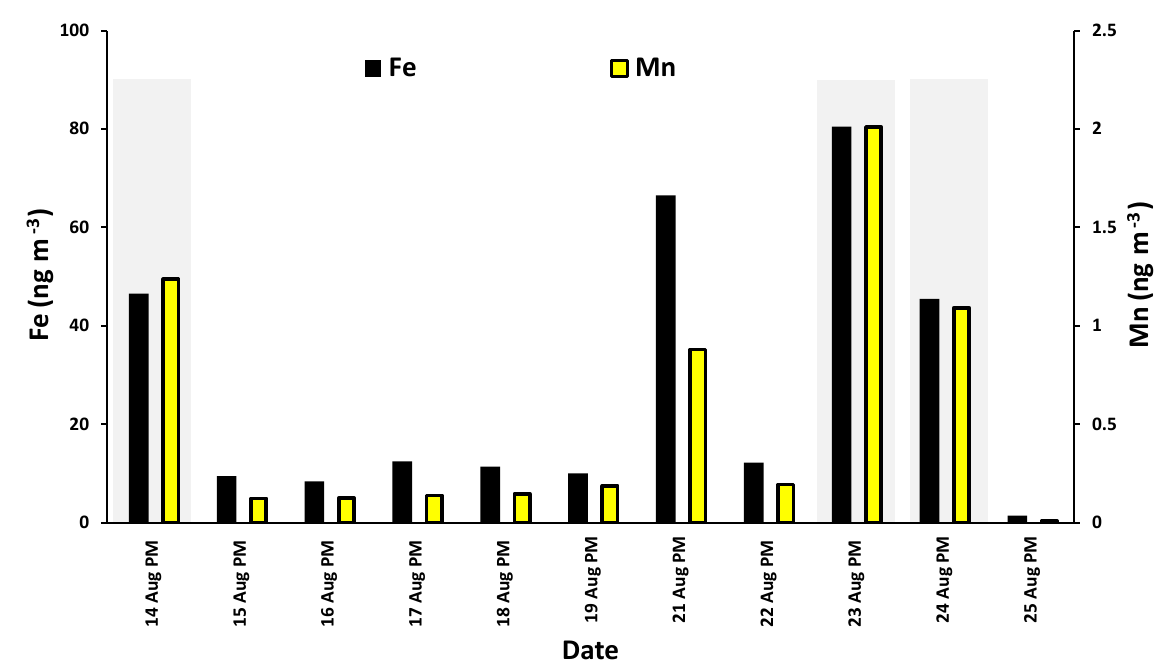
Figure A3. Concentrations of Fe and Mn during nighttime (PM) averaged during the high-volume sampler running periods.